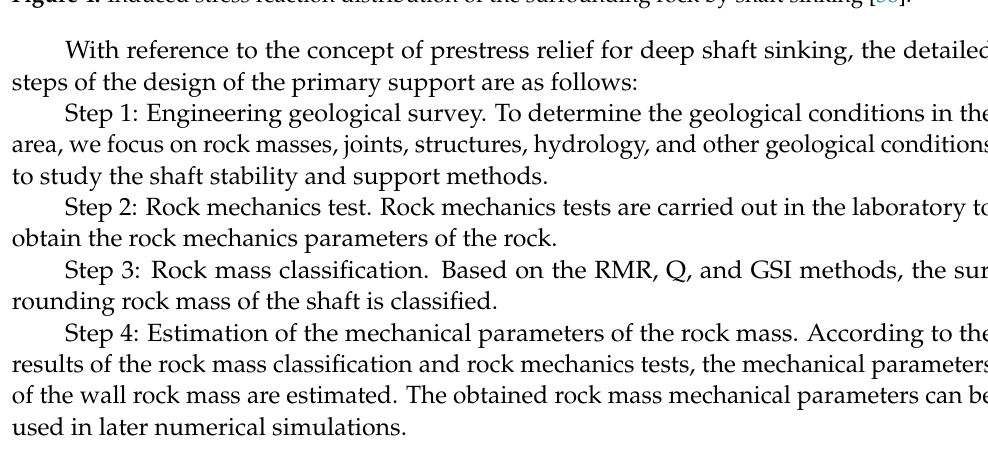
Figure 4. Induced stress reaction distribution of the surrounding rock by shaft sinking [38].